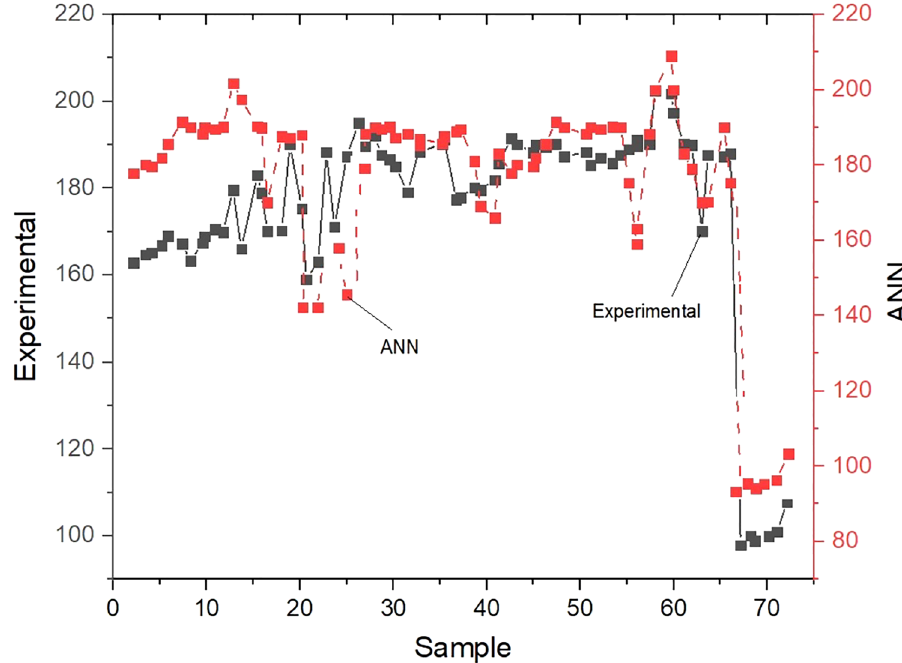
Fig. 6 Comparison between the neural network data and the real data in the tensile